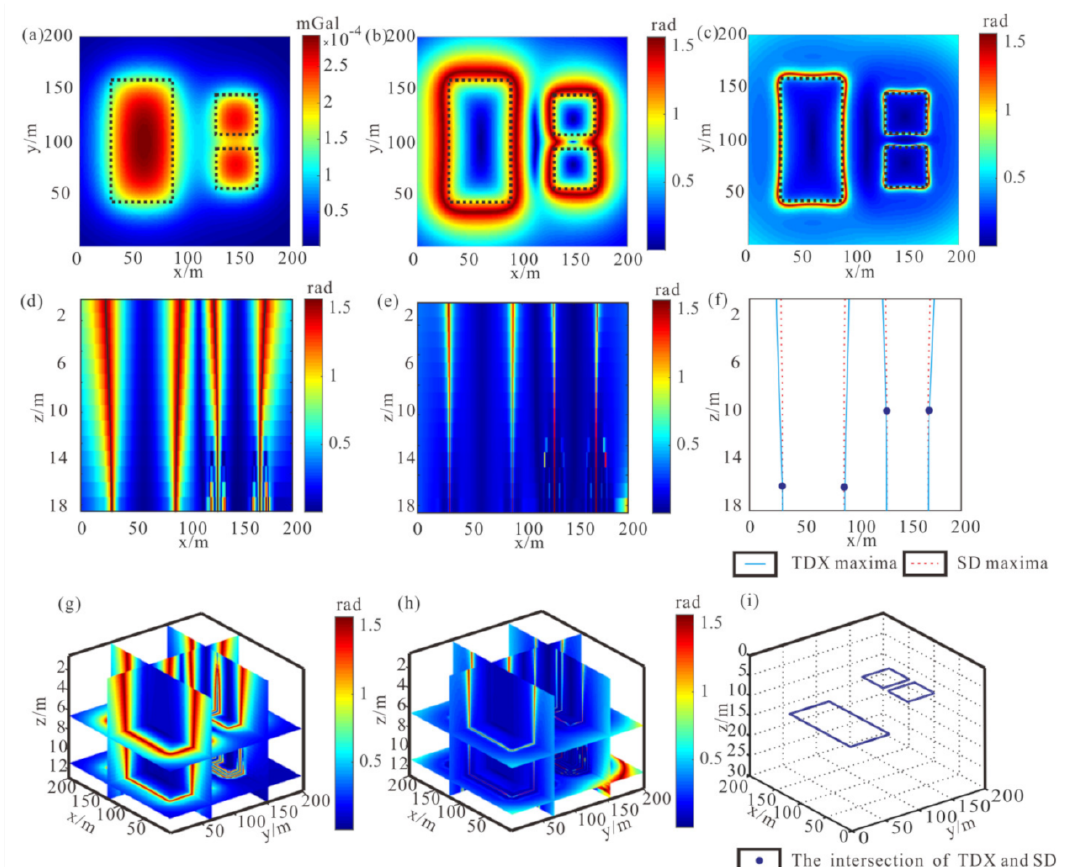
Figure 2. Imaging results of different-order vertical derivatives intersection of the prisms model: ( a ) Gravity anomaly of the prisms model on surface; ( b ) TDX result of gravity anomaly; ( c ) SD result of gravity anomaly; ( d ) TDX result of anomaly by downward continuation in the lower half space; ( e ) SD result of anomaly by downward continuation in the lower half space; ( f ) Imaging results of SDD; ( g ) x = 125 m slice of TDX 3D result; ( h ) x = 125 m slice of SD 3D result; ( i ) Imaging results of x = 125 m